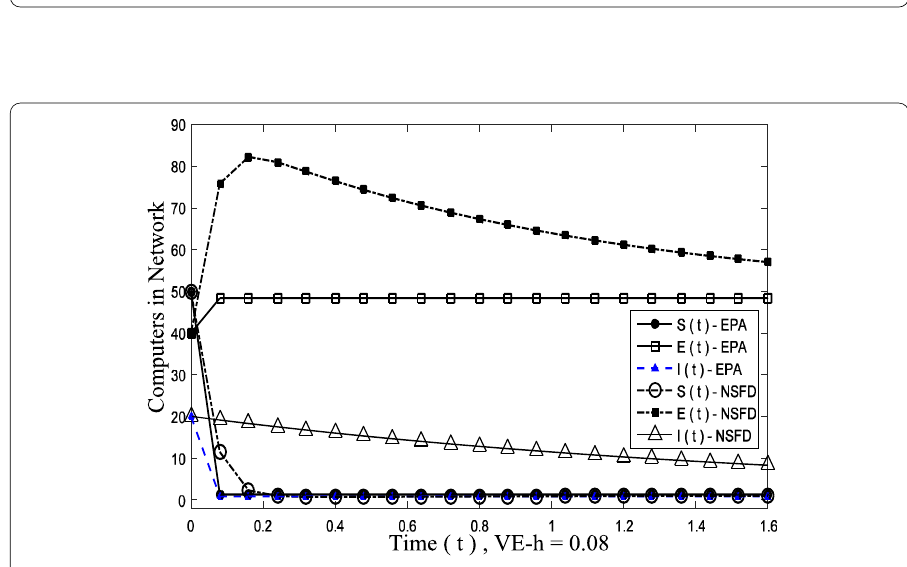
Figure 4 Convergence curves of EPA and NSFDE to VE point for h =